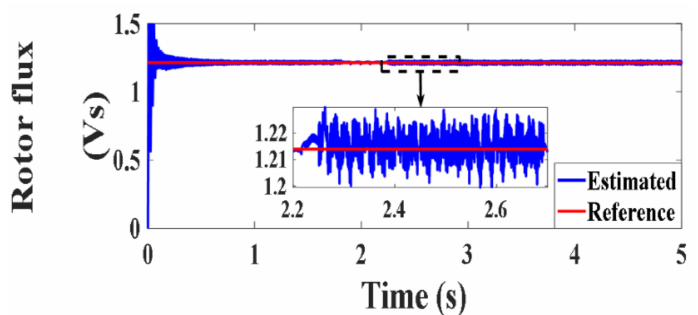
Figure 55. Rotor flux under PVC